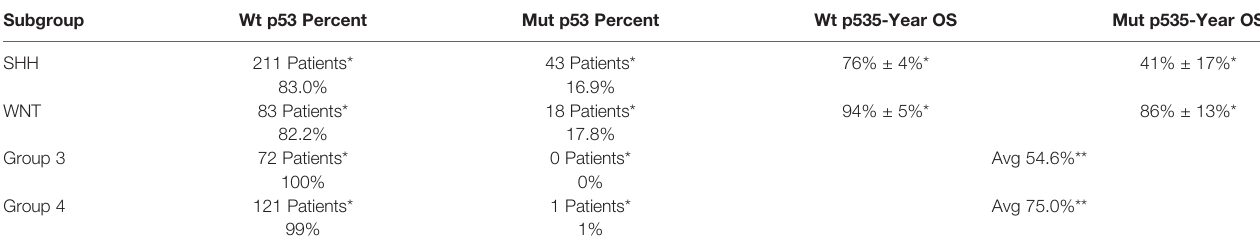
TABLE 1 | p53 mutation status and effect on medulloblastoma patient survival.